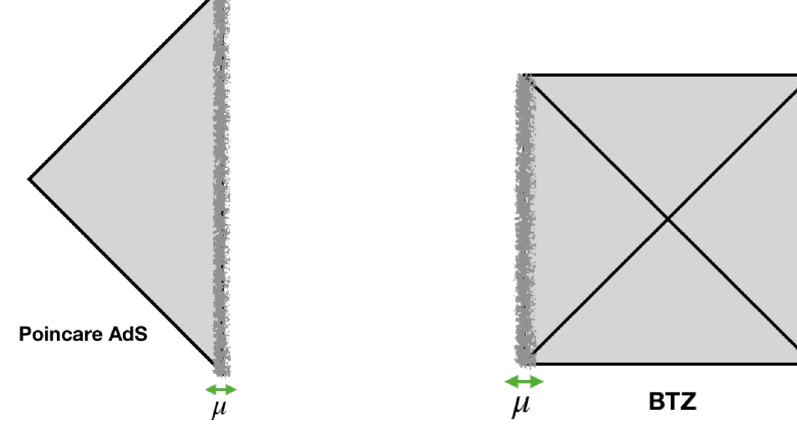
Figure 1 . The gravity dual of T (cid:22) T deformation: AdS 3 and BTZ black hole with random boundary geometry with the metric h ij that (cid:13)uctuates over the scale (cid:22) . The gravity dual is an ensemble of AdS 3 spaces or BTZ black